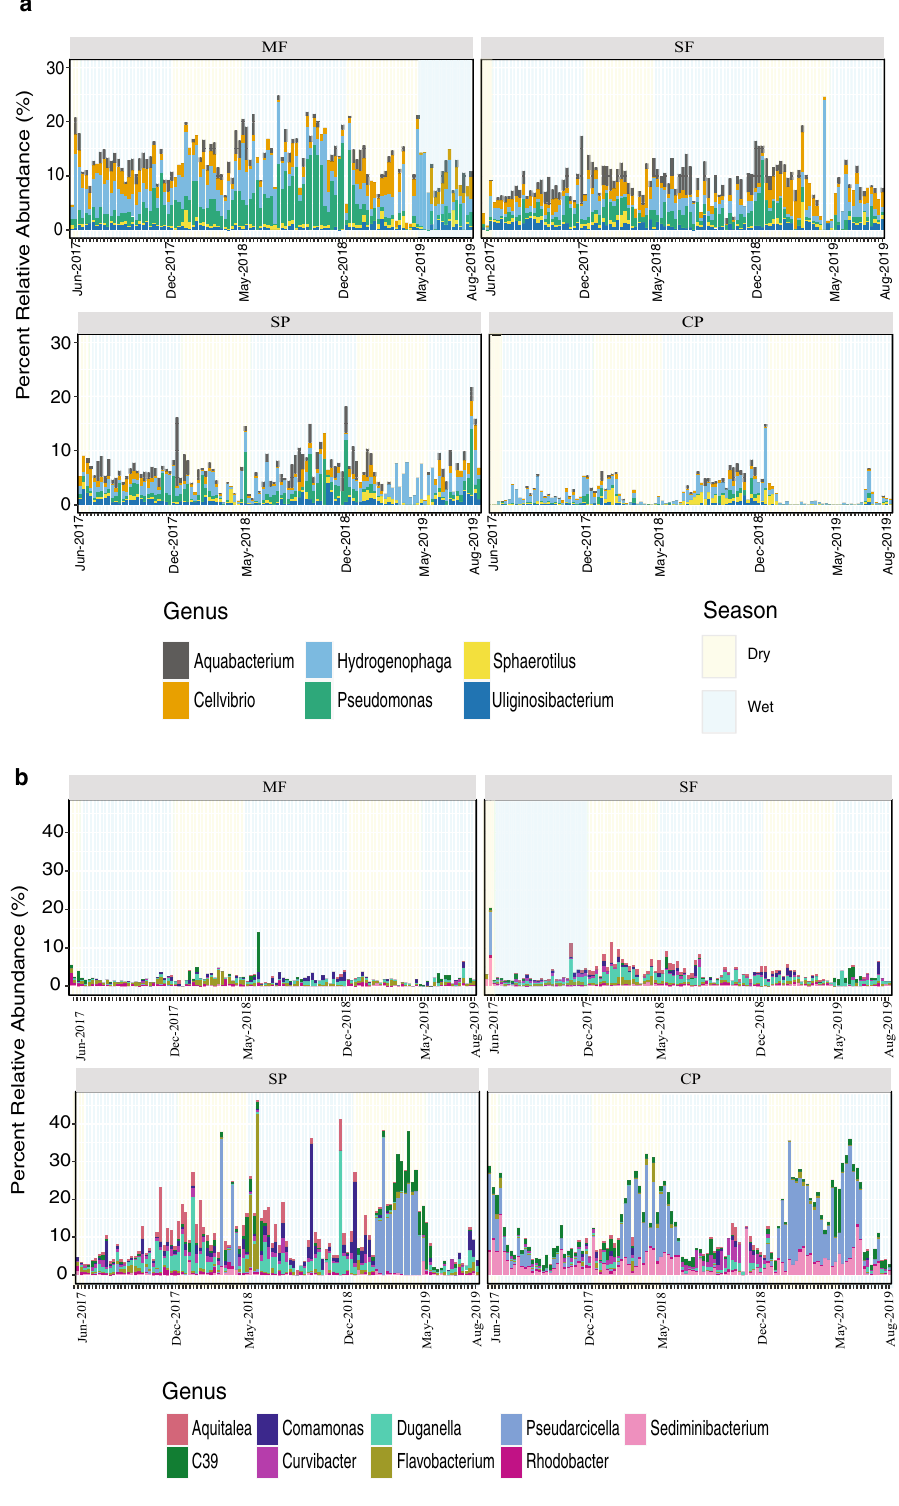
Figure 4. Indicator bacteria. Relative abundance of indicator genera for ( a ) forests and ( b ) pastures across the four land uses based on indicator taxa analysis (Indicspecies). Indicator genera with an overall relative abundance higher than 5% are shown. Colored bars in the plot backgrounds represent seasons. MF Mature Forest, SF Secondary Forest, SP Silvopasture, CP Traditonal Cattle